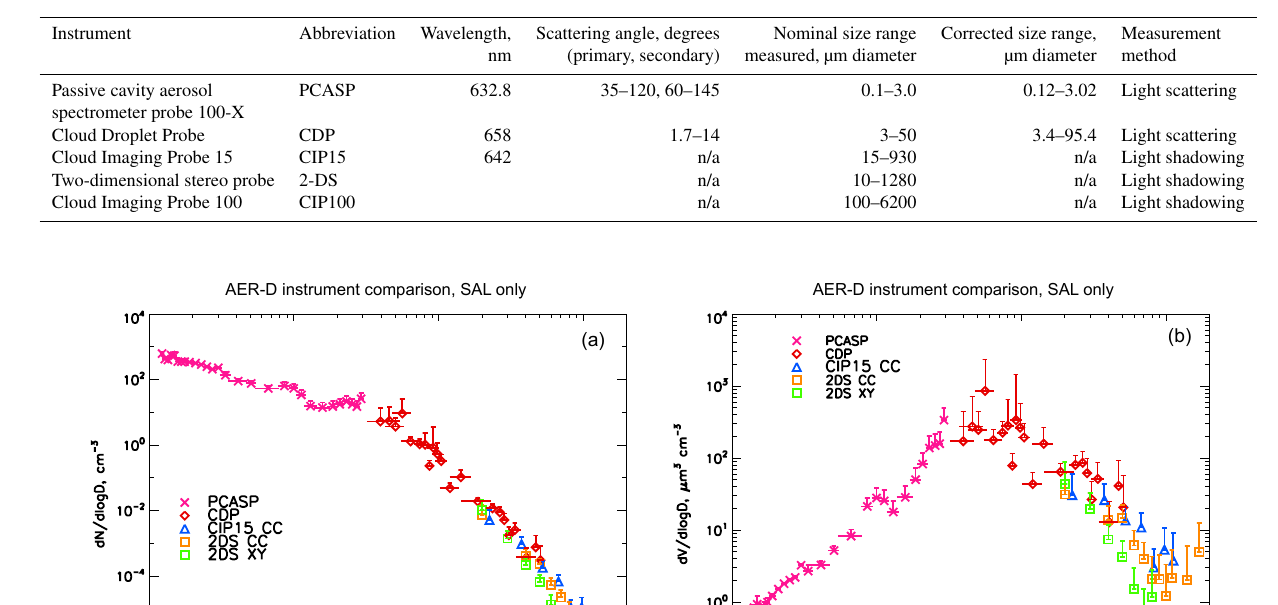
Table 3. Wing-mounted size distribution instrumentation operated during AER-D; n/a – not applicable.